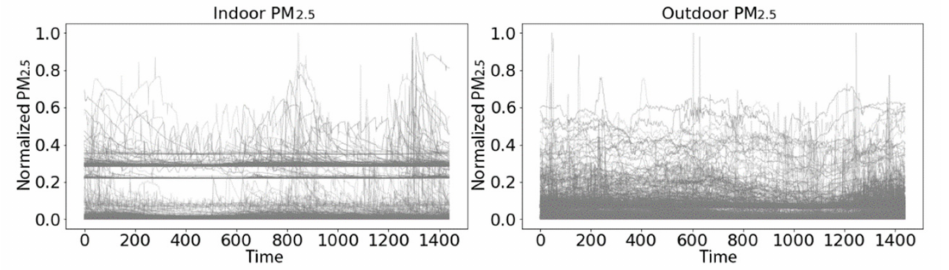
Figure 8. The 823 daily indoor ( left ) and outdoor ( right ) PM 2.5 time series, each 1440 min long (24 × 60), with the PM values scaled to min-max to plot on a unit